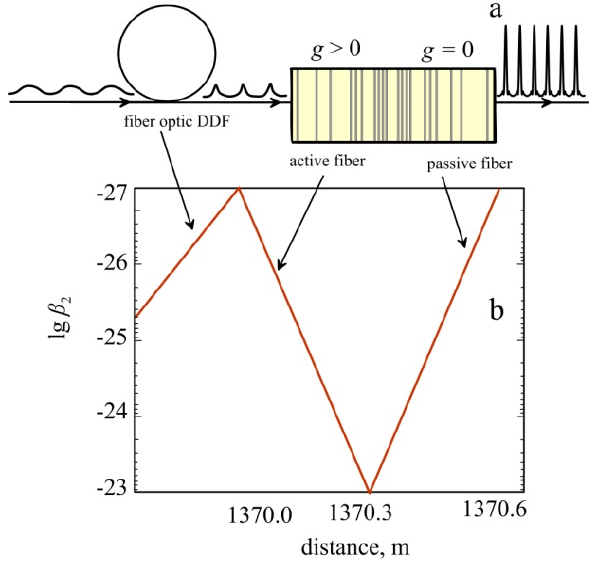
Figure 5. Fiber configuration comprising the DDF optical fiber and the cascade of active and passive fibers with inscribed FBG arrays ( a ). The GVD distribution over the fiber configuration length ( b ).